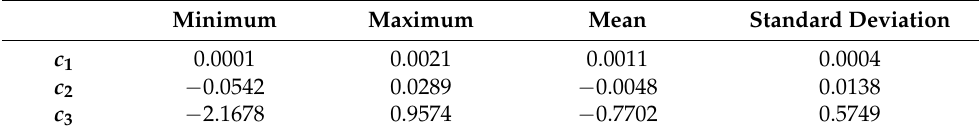
Table 4. Statistics of the coefficients c 1 , c 2 , and c 3 (Equation